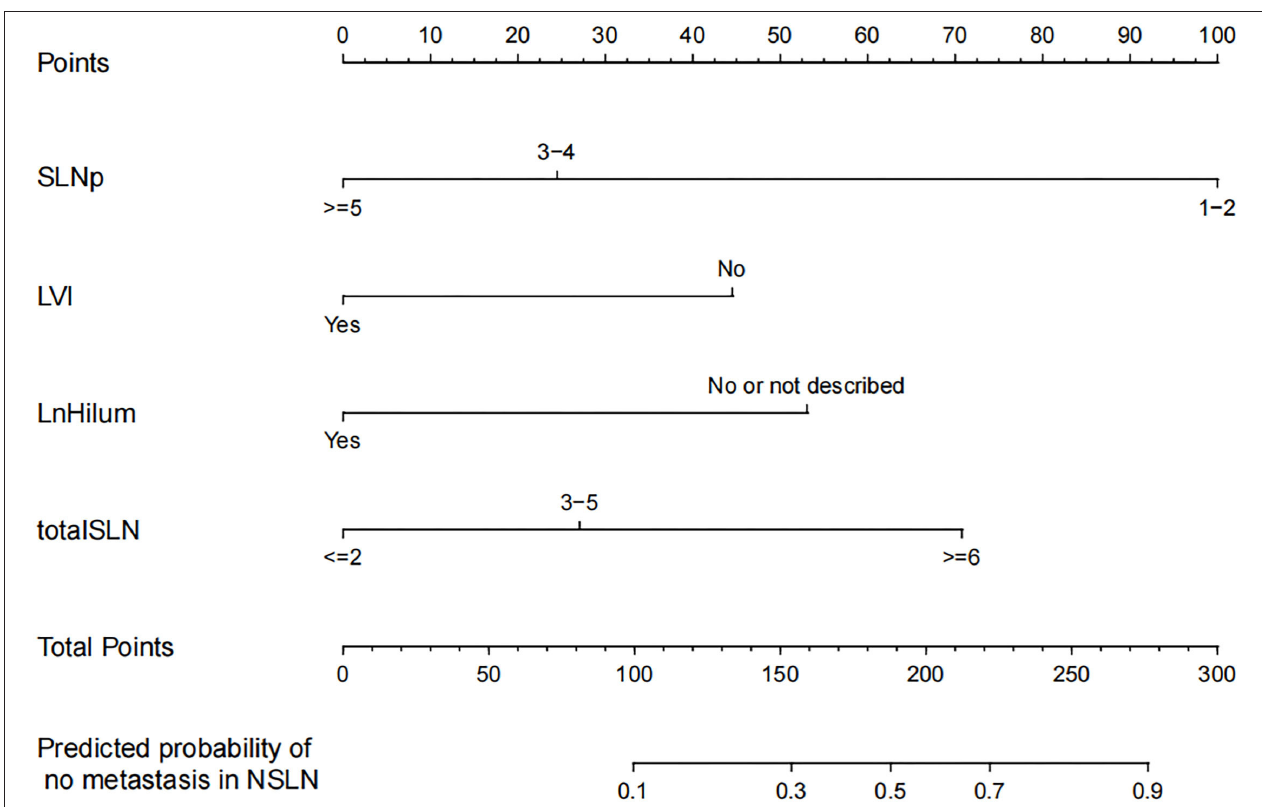
FIGURE 3 | Nomogram for prediction of the absence of non-sentinel lymph nodes (NSLN) metastasis. SLNp: number of positive SLNs; LVI: lymphovascular invasion; LnHilum: absence of lymph node hilum; totalSLN: total number of SLNs harvested.